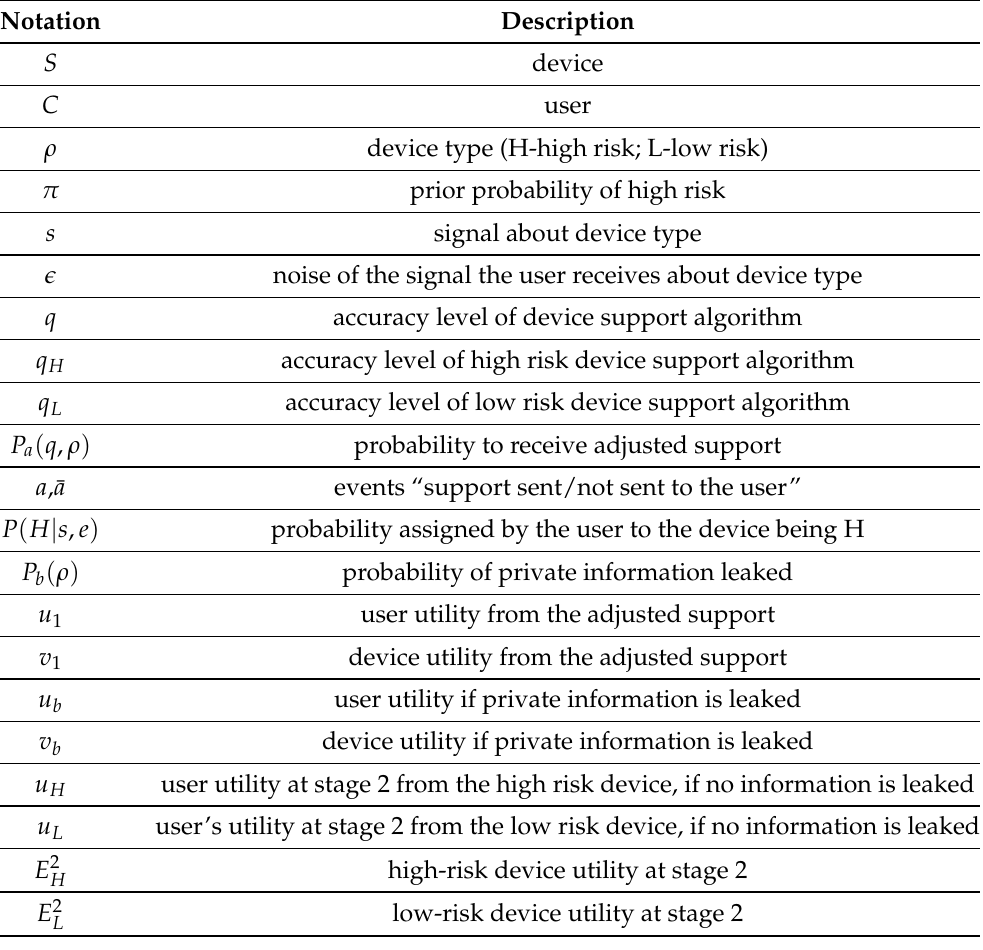
Table 1. List of notations in the